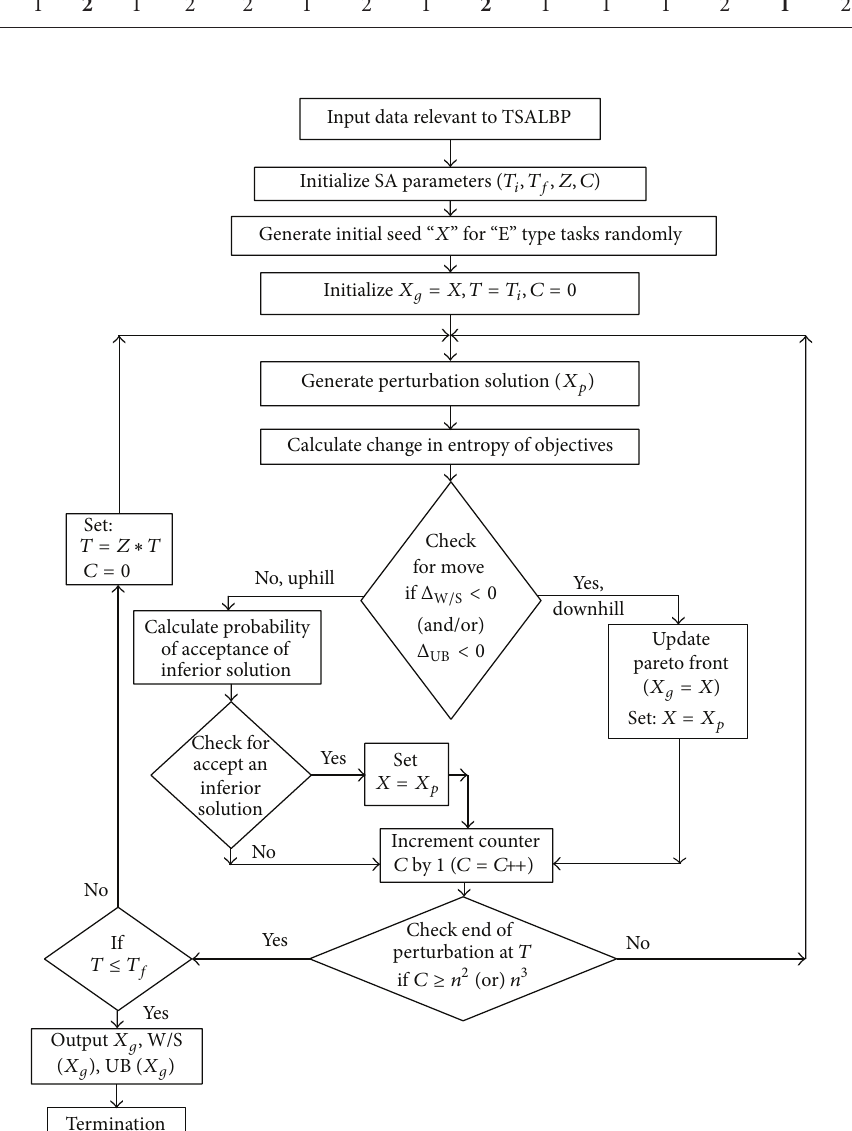
Figure 6: Framework of the proposed Simulated Annealing Algorithm for